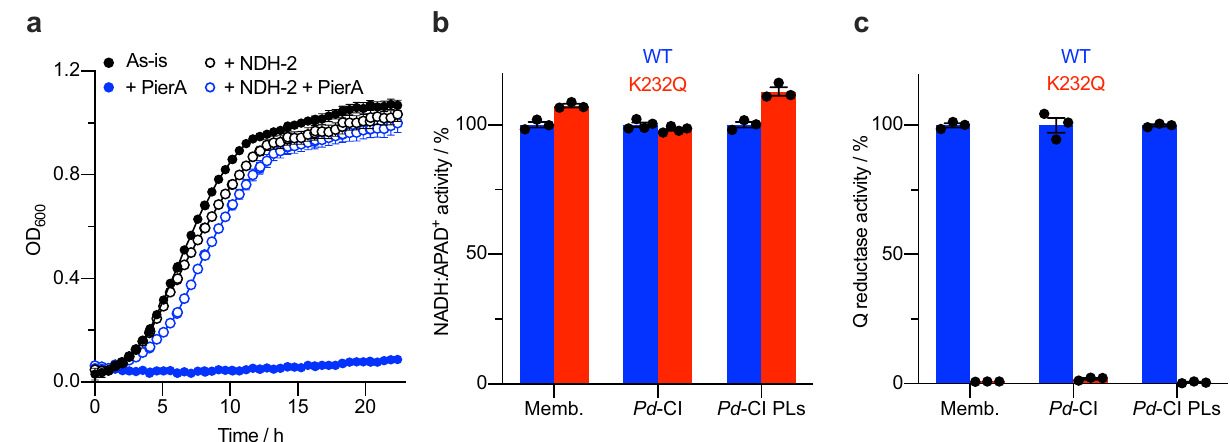
Figure 5. Creation of a catalytically inactive complex I variant. ( a ) Growth of wild-type P. denitrificans in succinate minimal media 40,41 . Cells were grown with/without 10 mM taurine to induce NDH-2 expression and with/without 5 µM piericidin A to inhibit complex I and cell growth. ( b ) Comparison of the complex I flavin site activity (NADH:APAD + ) of wild-type and the K232Q Nqo13 variant measured in three different contexts. Membrane activities were measured using dNADH due to the expression of NDH-2 during cell growth. The specific activities have been normalized to the wild type activities; in membranes (0.527 ± 0.006 µmol min – 1 mg –1 , S.E.M. n = 3), purified CI (12.13 ± 0.14 µmol min –1 mg –1 , S.E.M. n = 4), and proteoliposomes (10.71 ± 0.12 µmol min –1 mg –1 , S.E.M. n = 3). ( c ) Comparison of the quinone reductase activity (Q 10 or DQ) of wild-type and the K232Q Nqo13 variant measured in three different contexts. The specific activities have been normalized to the wild type activities (minus the average piericidin A insensitive rates) in membranes (2.41 ± 0.02 µmol min –1 mg –1 , S.E.M. n = 3), purified enzyme (19.73 ± 0.058 µmol min –1 mg –1 , S.E.M. n = 3), and proteoliposomes (41.45 ± 0.17 µmol min –1 mg –1 , S.E.M. n =